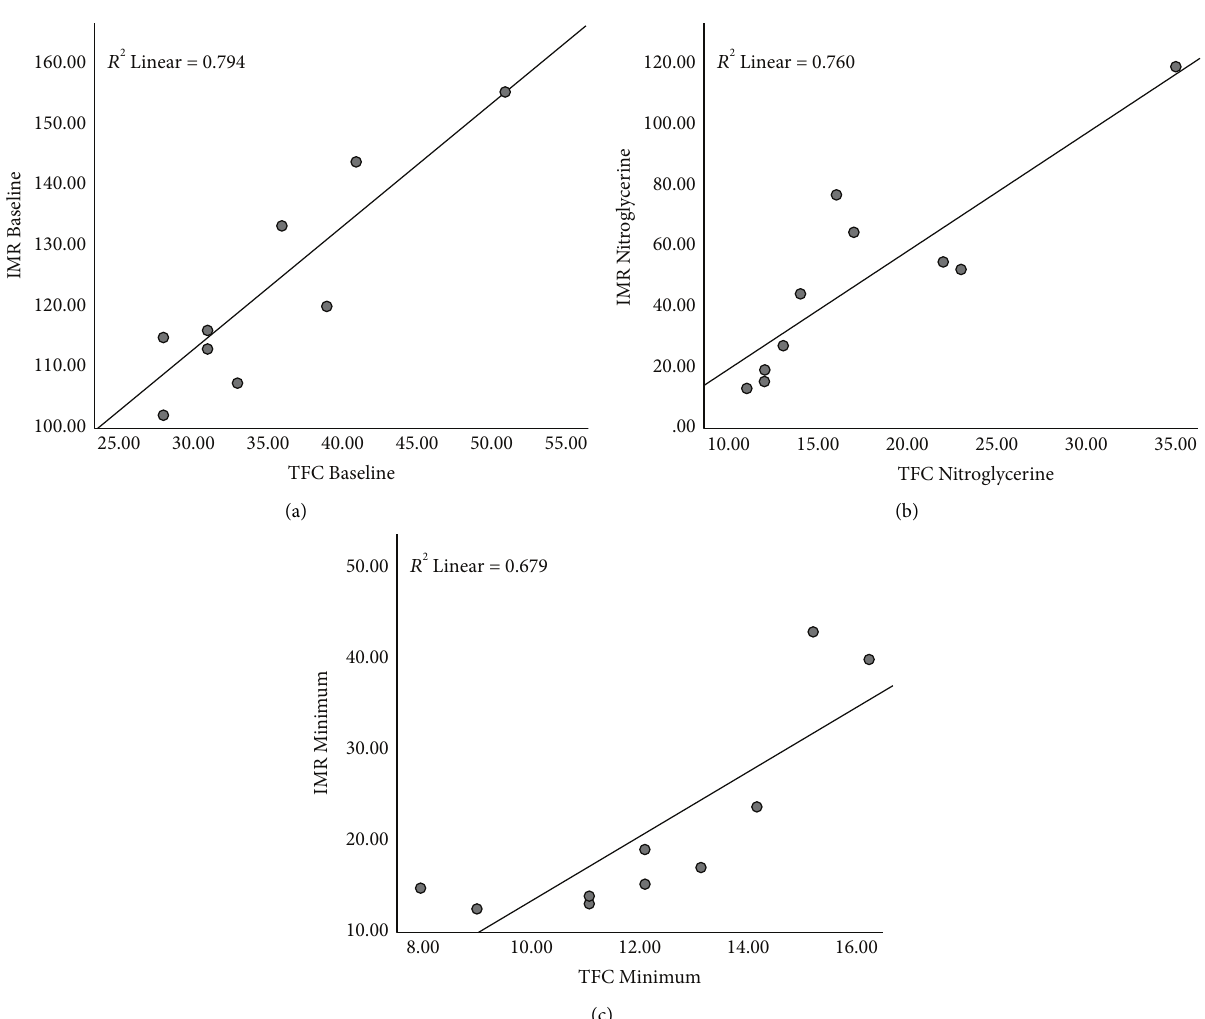
� 0.775, P � 0 . 08). (b) TFC Base was significantly correlated with IMR Base ( r Nit was